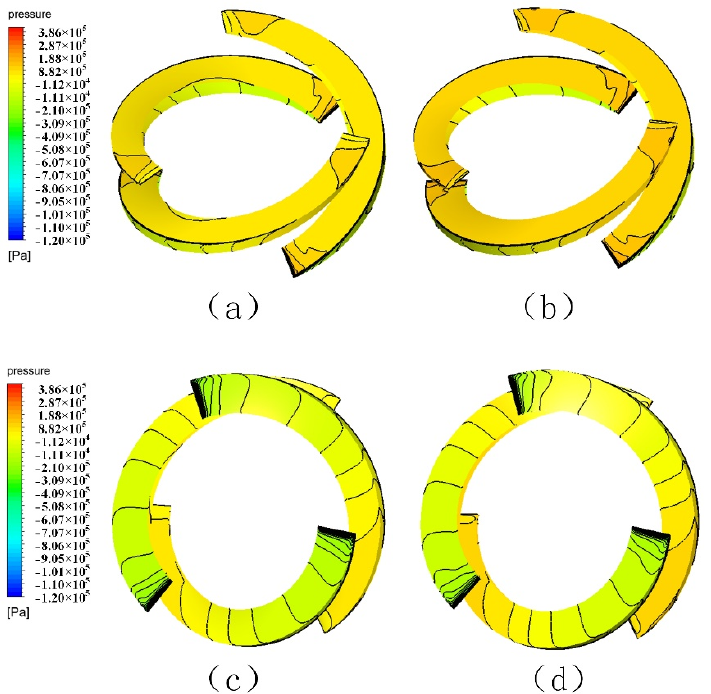
Figure 10. Surface static pressure distribution of the impeller in water condition. ( a ) Pressure side of original model; ( b ) pressure side of optimized model; ( c ) suction side of original model; ( d ) suction side of optimized model.